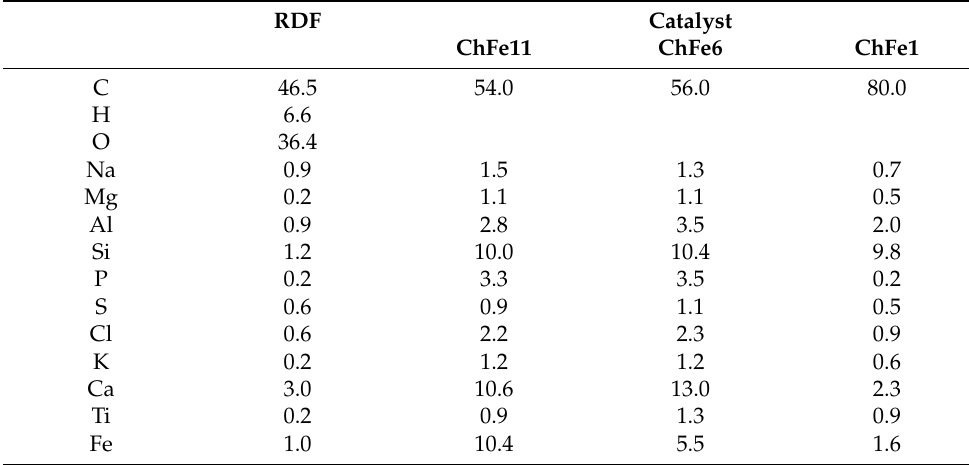
Table 3. Elemental analysis (wt%) of RDF and catalysts from